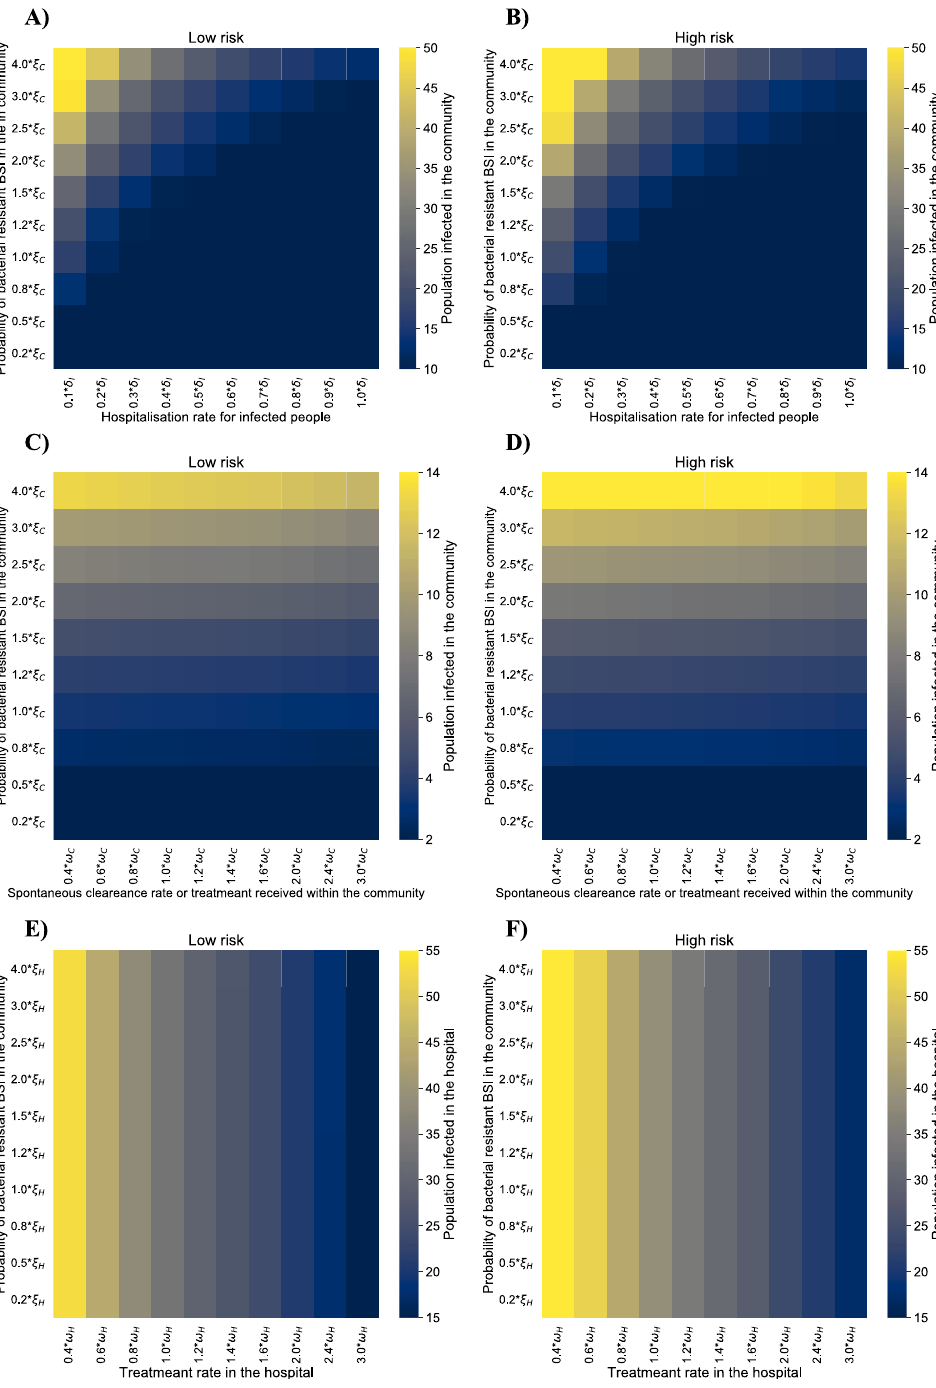
Figure 4. Bivariate analyses result of the main parameters on the number of infections in the community (panel A – D ) and hospital (panel E – F ), by risk group. Notes: A and B show a bivariate analysis of the hospitalisation rate for individuals with a GN-ARB BSI and the probability of developing GN-ARB BSI, both in the community, on the number of individuals having GN-ARB BSI in the community. Figures ( C ) and ( D ) depict the variation of the probability of GN-ARB BSI and the spontaneous clearance (or treatment rate), both in the community. Figures ( E ) and ( F ) display the bivariate relationship between the probability of GN-ARB and treatment rate, both in the hospitals, on the number of people having GN-ARB in the same setting. Lighter (yellow) colours mean a higher number of people infected by GN-ARB, whereas darker (blue) colours mean